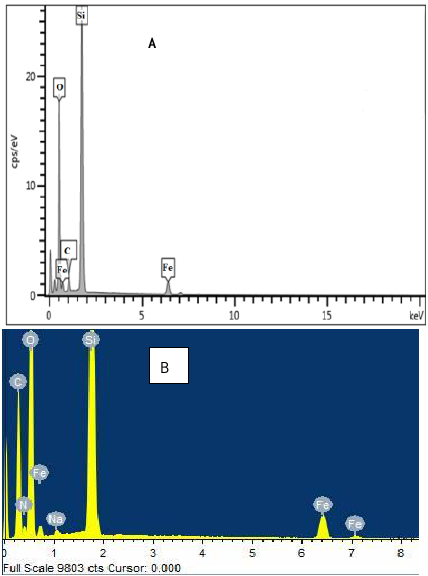
Figure 4. SEM-EDS spectra of ( a ) Fe 2 O 3 -SiO 2 nanocomposite and ( b ) Fe 2 O 3 -SiO 2 -PAN.